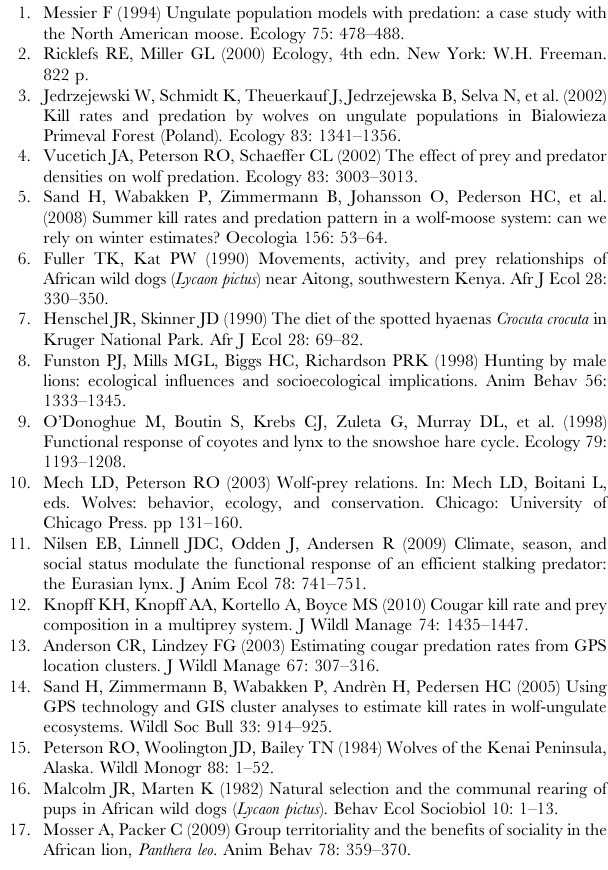
period for carcass detection (i.e., 1 day for small ungulates, 3 days for large ungulates). Table S1 Pack affiliation for individual wolves during winter monitoring periods, 1997–2009. Text S1 Description of the GPS collar used during summer 2004. Text S2 Investigation of single, isolated GPS